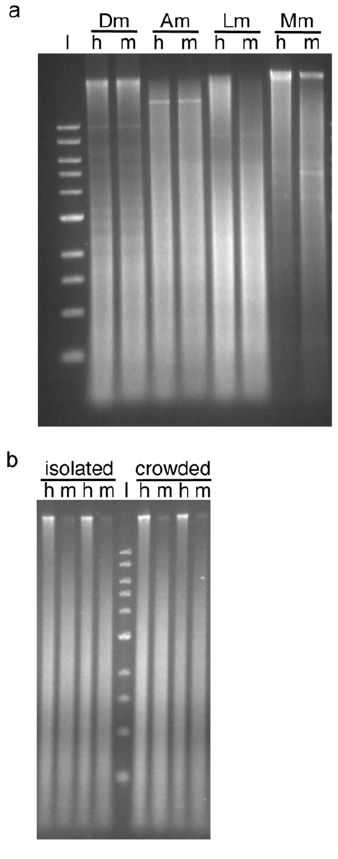
Figure 1. Extant genome-wide methylation. (a) DNA extracted from adult head tissue of D. melanogaster (Dm), A. mellifera (Am) and L. migratoria (Lm) and 3T3 fibroblasts of M. musculus (Mm) was digested separately with Hpa II and Msp I. Approximately 1 m g of DNA per digest was loaded onto the gel. L, NEB 1 KB ladder; h, Hpa II; m, Msp I. (b) Hpa II/ Msp I digested L. migratoria egg DNA. Tissue for DNA extraction was pooled from four individuals per egg pod. Each egg pod was obtained from a different mother. Approximately 1 m g of DNA per digest was loaded onto the gel. Lanes 1–4, isolated pods 1 and 2 respectively; lanes 6–9, crowded pods 1 and 2 respectively. Data presented here are representative of the ten replicates performed per treatment.